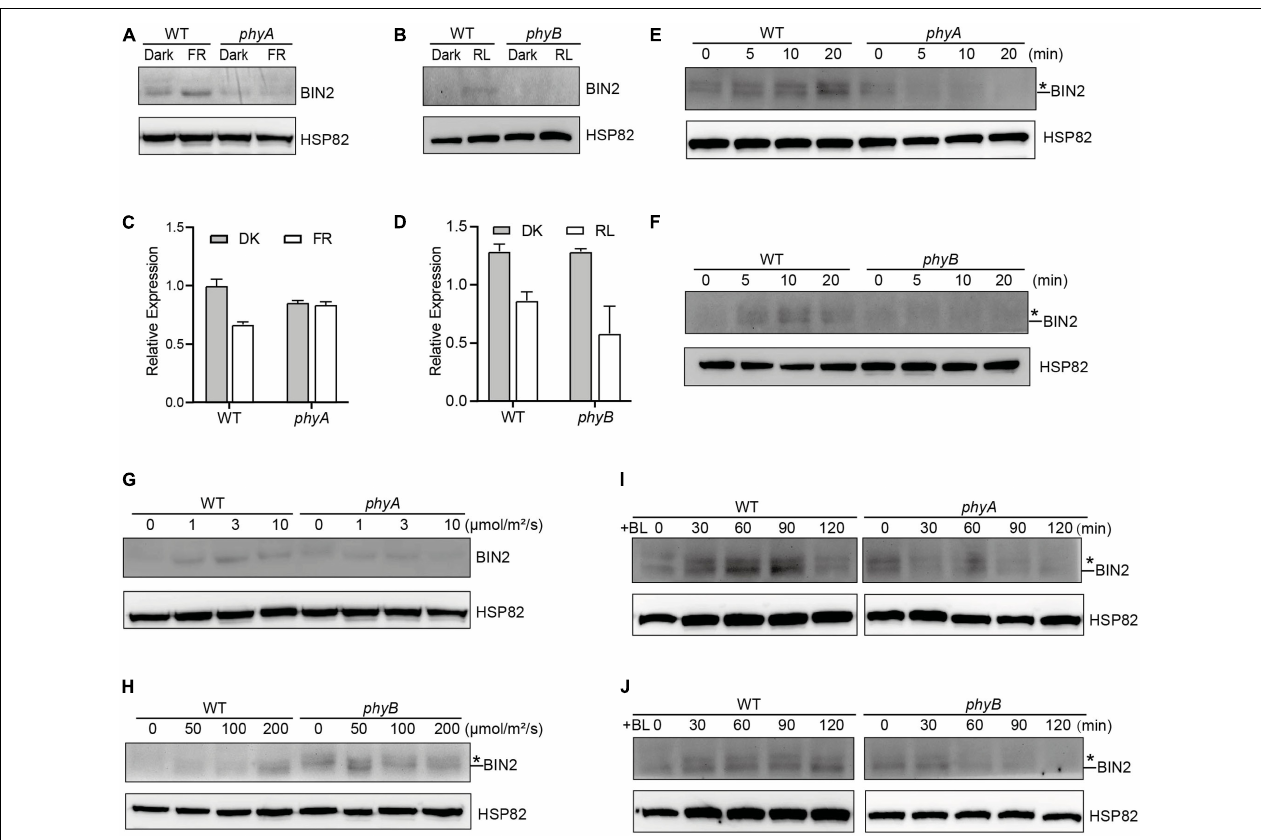
FIGURE 1 | phyA and phyB Mediate Far-Red and Red lights Inhibition of BL-Induced Degradation of BIN2 Protein. (A, B) Western blotting assays showing phyA- and phyB-mediated far-red or red light inhibition of degradation of BIN2 protein. WT, phyA and phyB mutant seedlings were grown on MS plates in continuous darkness (DK) or far-red light (FR, 1 µ mol/m 2 /s) (A) or red light (R, 50 µ mol/m 2 /s) (B) for 5 d. (C, D) RT-qPCR assays showing the regulation of BIN2 expression by phyA or phyB in (A) and (B) . Data correspond to the mean and standard deviation from three technical replicates. (E, F) Western blotting assays showing the effects of different exposure times of far-red or red light on the degradation of BIN2 protein. WT, phyA and phyB mutant seedlings were grown on MS plates supplemented with 2 µ M BRZ in darkness for 7 d, and then exposed to far-red light (10 µ mol/m 2 /s) (E) or red light (100 µ mol/m 2 /s) (F) for the indicated lengths of time. (G, H) Western blot assays showing the effects of far-red or red light intensity on the degradation of BIN2 protein. WT and phyA mutant seedlings were grown on MS plates in far-red light at the fluence rates of 0, 1, 3, and 10 µ mol/m 2 /s for 5 d, respectively (G) ; WT and phyB mutant seedlings were grown on MS plates supplemented with 2 µ M BRZ in darkness for 7 d, and then exposed to the indicated light intensities of red light (H) for 30 min. (I, J) Western blot assays showing the effects of phyA or phyB on the BL-induced degradation of BIN2 protein. WT, phyA and phyB mutant seedlings were grown on MS plates supplemented with 2 mM BRZ in darkness for 7 d, and then treated with 1 mM BL, and then exposed to far-red (10 µ mol/m 2 /s) (I) or red light (100 µ mol/m 2 /s) (J) for the indicated lengths of time. Asterisks shown in (E) , (F) , (H) , (I) , and (J) denote the possible modified BIN2 protein upon BRZ treatment.